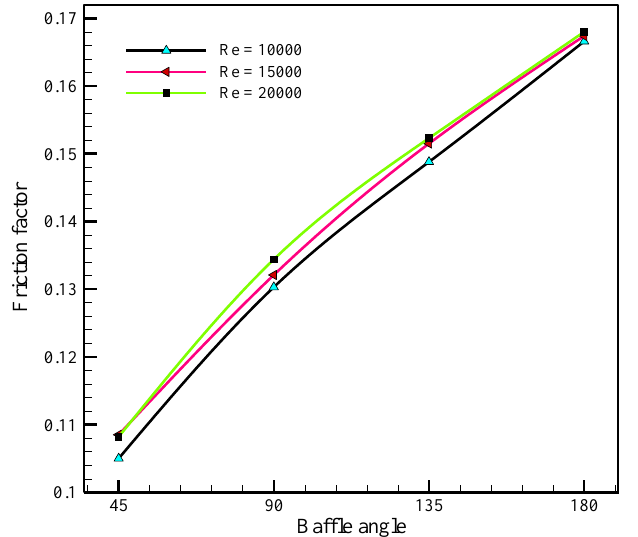
Figure 12. Variation of friction factor against baffle angle for 0.1% solid volume fraction at different Reynolds numbers.